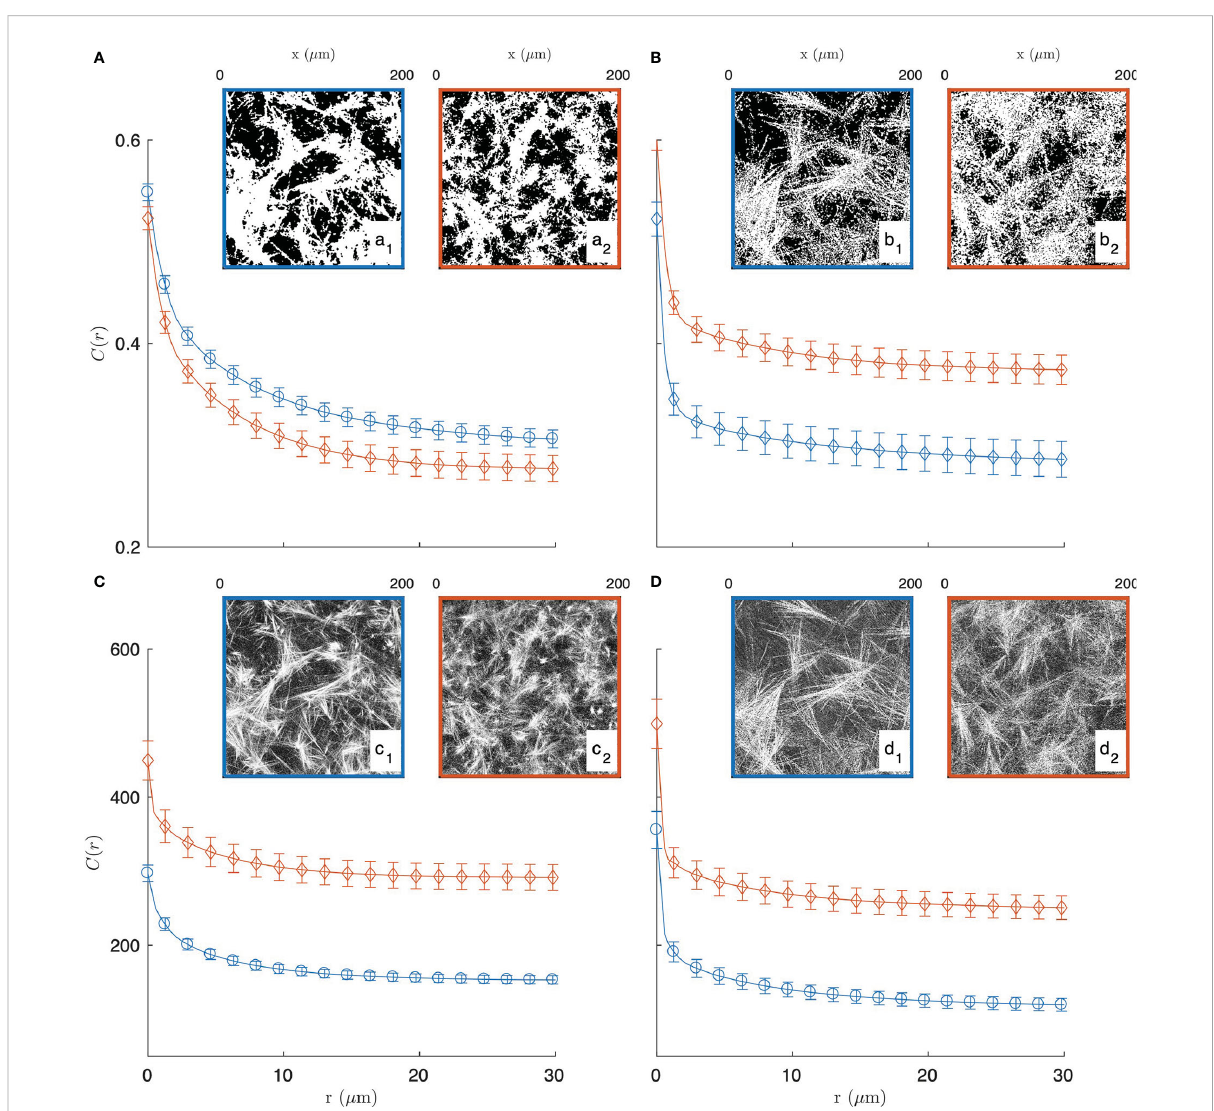
FIGURE 2 Experimental covariance (top) and grey-tone correlation function (bottom) of the 2 mg/mL (blue circle, a1, b1, c1, d1 ) and 3 mg/mL (red diamond, a2, b2, c2, d2 ) gels, imaged in fl uorescence (A, C) and re fl ectance (B, D) modes. The insets display one of the fi fteen images used for each condition, and the error bars are the standard errors of the